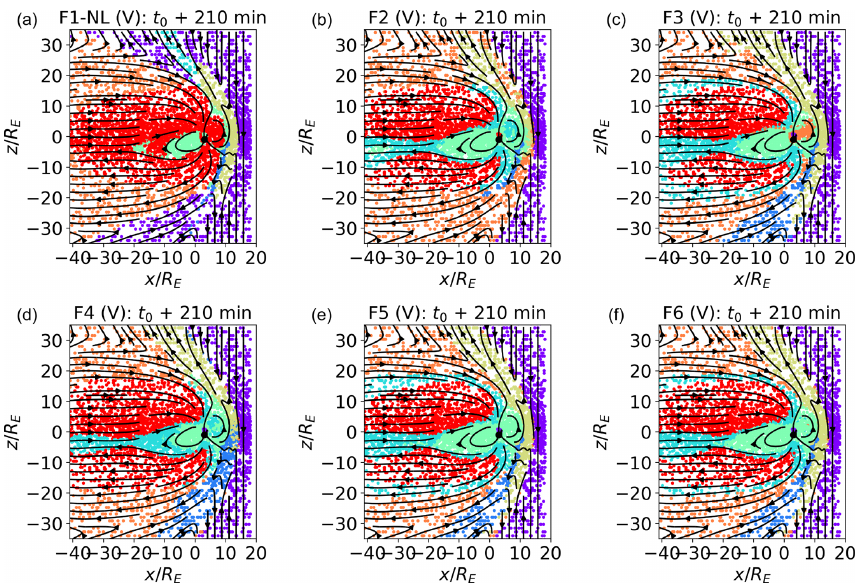
Figure 8. Validation plots at t 0 + 210min in the y/R E = 0 plane from SOMs trained with feature sets F1 NL, F2, F3, F4, F5, and F6. F1 NL uses density, pressure, and temperature rather than their logarithms. F2 does not include log (n) , and F3 does not include v x . F4, F5, and F6 add the logarithms of Alfvén speed v A , the Alfvénic Mach number M A , and the plasma beta β , respectively, to the feature set F1.